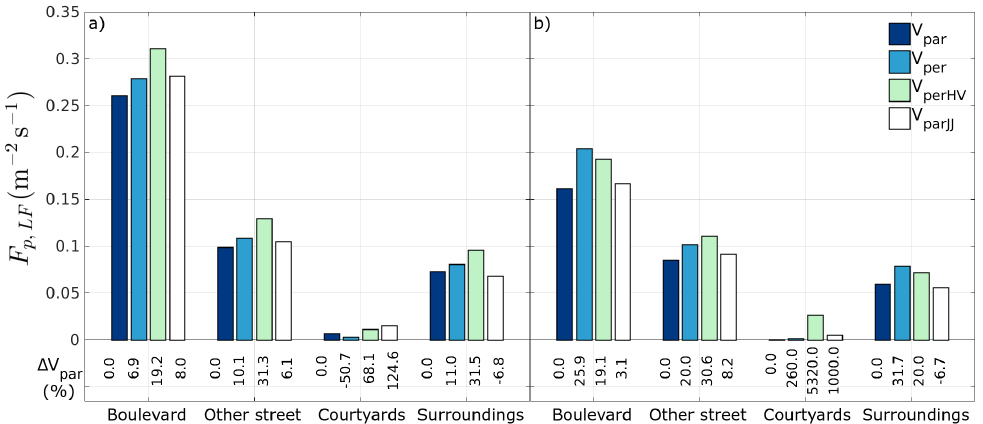
Figure 10. Horizontal mean of the low-frequency vertical turbulent particle flux density F p , LF (m − 2 s − 1 ) under the ( a ) general and ( b ) wintry inflow conditions separately for the boulevard, other street canyons, courtyards and surroundings at z = 20 m for all runs. The difference to the value in V par is given in percentages ( ∆ V par